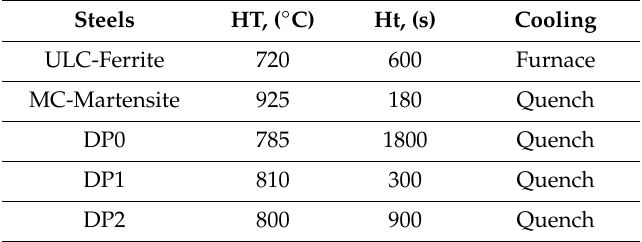
Table 2. Heat treatment parameters. HT and Ht are acronyms for holding temperature and holding time